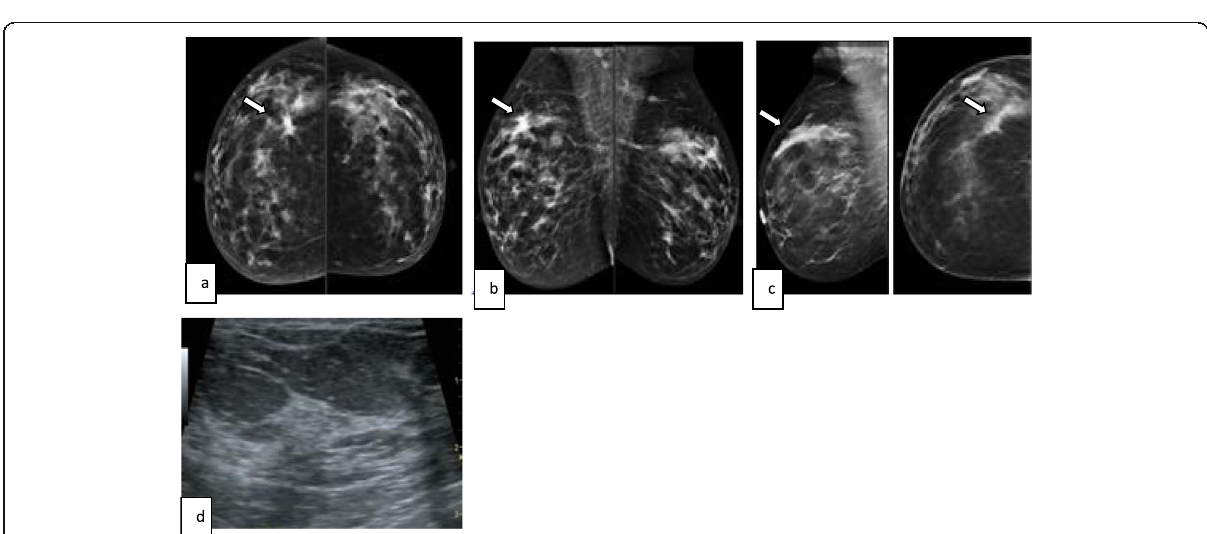
Fig. 11 (Case no. 4) A 26-year-old patient. She came for mastalgia with high-risk positive family history (two first-degree relatives). Mammography revealed breast density: ACR C. Right upper outer quadrant focal asymmetry (BIRADS4) ( a , b ). 3D tomosynthesis revealed: right upper outer quadrant normal parenchymal tissue (BIRADS 1) ( c ). Breast ultrasound revealed hyperehoic parenchyma with mottling appearance denoting adenosis (BIRADS 1) ( d ). Final diagnosis: breast